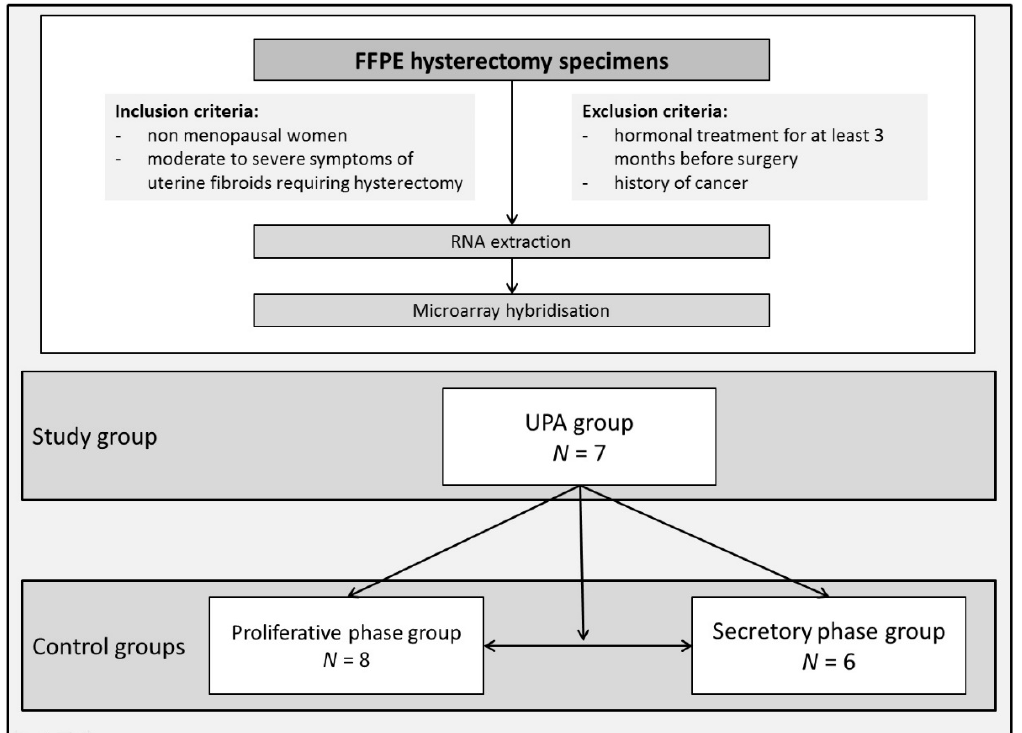
Figure 1. Flow chart. RNA was extracted from FFPE hysterectomy specimens from 21 non-menopausal women presenting moderate to severe symptoms of myoma requiring hysterectomy. The study group included 7 women operated on after a 3-month course of UPA, before treatment discontinuation. Two control groups consisted of 8 hysterectomy samples obtained in the proliferative phase and 6 hysterectomy samples obtained in the secretory phase. FFPE: Formalin-fixed, paraffin-embedded; UPA: Ulipristal acetate